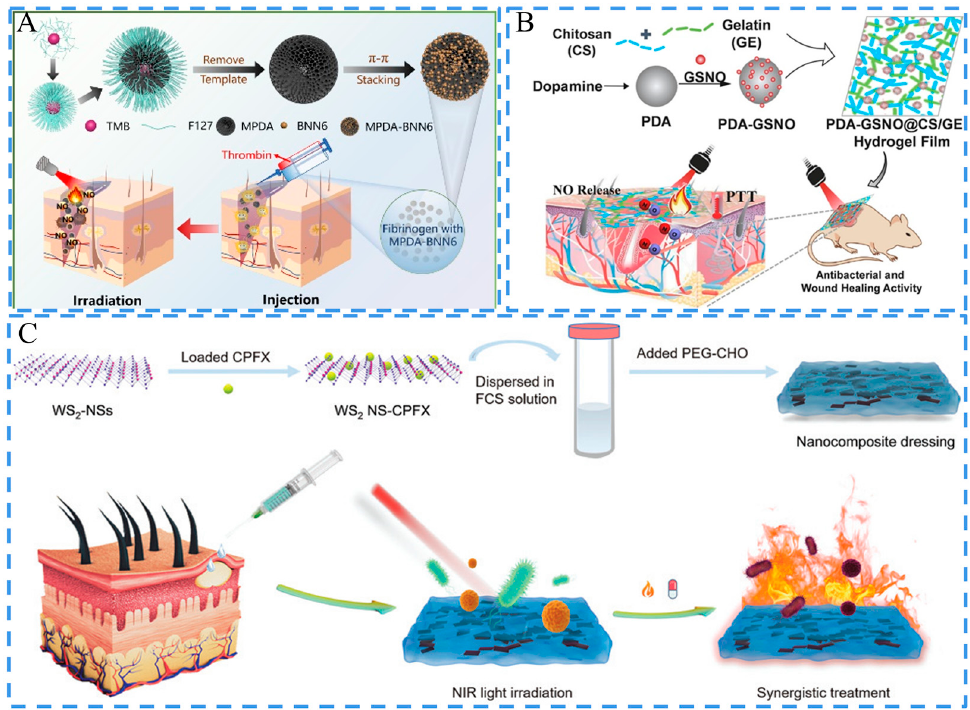
Figure 8. Schematics of the photo-responsive hydrogels. ( A ) Schematic of the fabrication and application of the hydrogel MPDA-BNN6@fibrin in anti-infective therapy and wound healing. Reproduced with permission [160]. Copyright 2022, Elsevier. ( B ) Schematic of synthetic procedure and NIR-triggered PTT and NO therapy of the hydrogel PDA-GSNO@CS/gelatin for enhanced wound healing. Adapted with permission [161]. Copyright 2022, Elsevier. ( C ) Schematics of the preparation procedure for WS 2 -CPFX/FCS/PEG-CHO hydrogel and the synergistic therapy of an infected wound. Adapted with permission [172]. Copyright 2020, Elsevier.